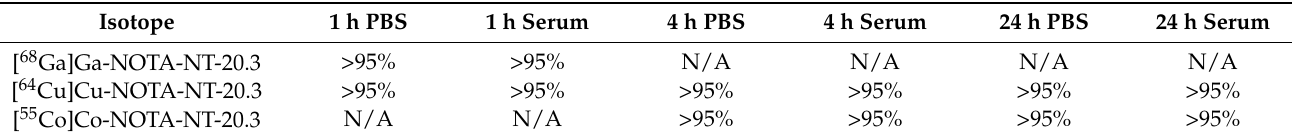
Table 2. Stability of radiolabeled NOTA-NT-20.3 in PBS and human serum.